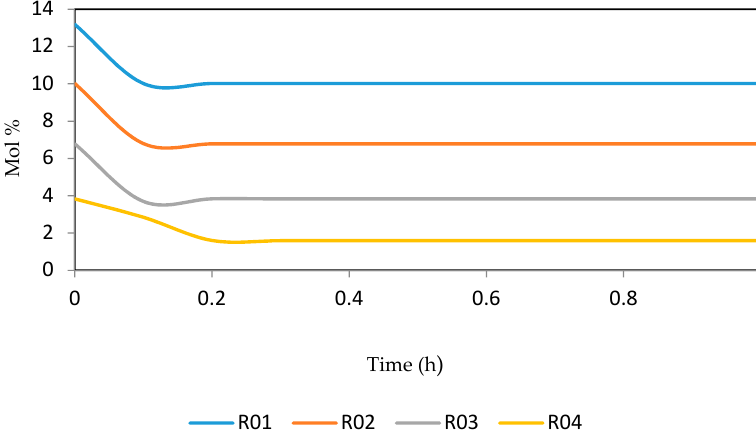
Figure 22. Dynamic behaviour of N 7 in the four reactors.